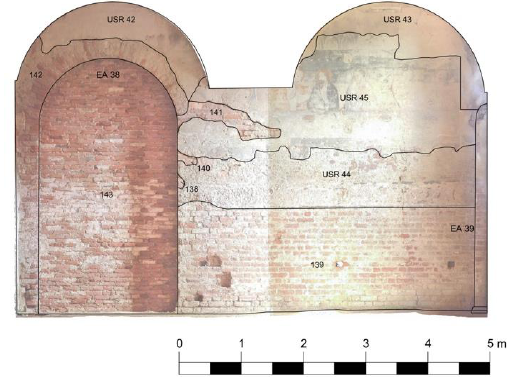
Figure 2. East Wall of the Refectory and its